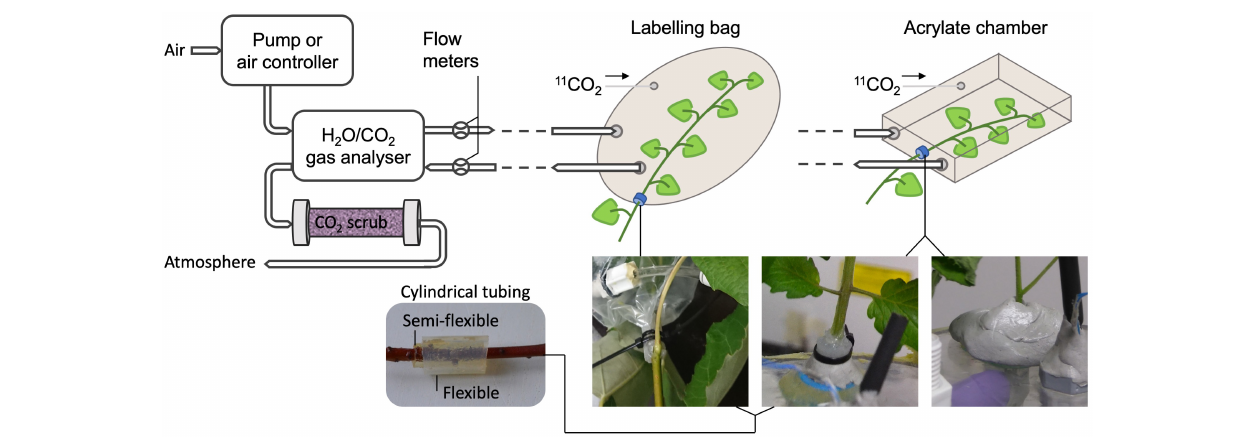
FIGURE 3 | Schematic showing a potential set-up of an air circulation system of a PET experiment using gaseous 11 CO 2 (top) with specific examples to hermetically seal a plant part (bottom). Air flow is typically provided by a pump or another air controlling device to the plant tissue that will be labeled with 11 CO 2 . Photosynthesis and transpiration can be obtained by a gas analyzer measuring CO 2 and H 2 O content, respectively, of the incoming and outgoing air of the labeling system. Flow meters are used for detection of undesired leaks in the labeling system. At the end of the circulation system, the air can be scrubbed from 11 CO 2 before being released to the atmosphere. The bottom pictures show effective methods for enclosing part of a plant organ in a labeling bag or an acrylate feeding chamber, while hermetically sealing it from the atmosphere and other plant parts without damaging the tissue. The plant organ can for instance be enveloped by (multiple) small cylindrical flexible pieces of tubing, which are lubricated with petroleum jelly on the inside (bottom left). Straps can then be tightened upon the tubing (bottom middle) to close the labeling bag or fix the plant position in the acrylate chamber. Consecutive application of a stiff semi flexible and a soft flexible piece of tubing ensures airtightness without tissue damage when cable ties are tightened. Alternatively, malleable polysiloxan material can be used (bottom